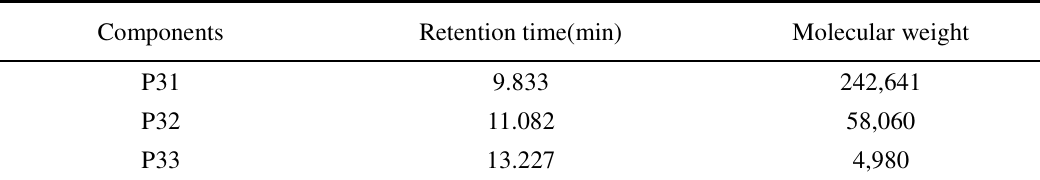
Table 2. The retention time and molecular weight of polysaccharides from